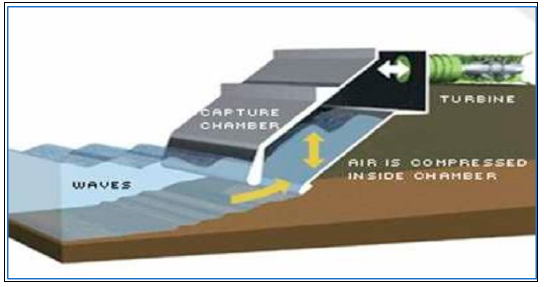
Figure 8. Islay Island OWC system Voith Hydro [32].